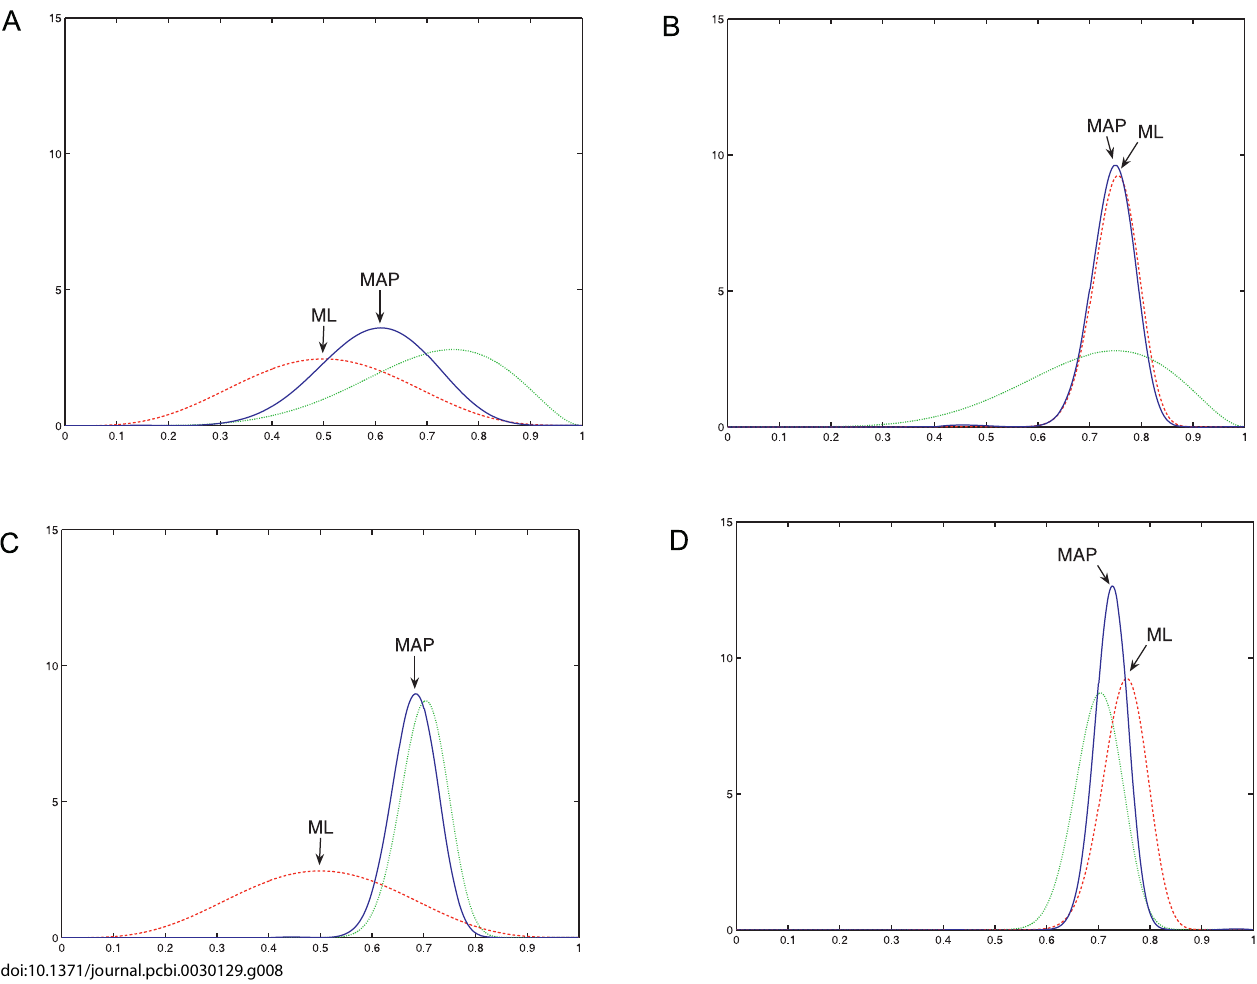
Figure 8. The Effects of Different Strength Priors and Training Set Sizes (A) In this case, the observed data is ten interaction sites, of which five have high conservation, five low. As expected, in this case the likelihood peaks at